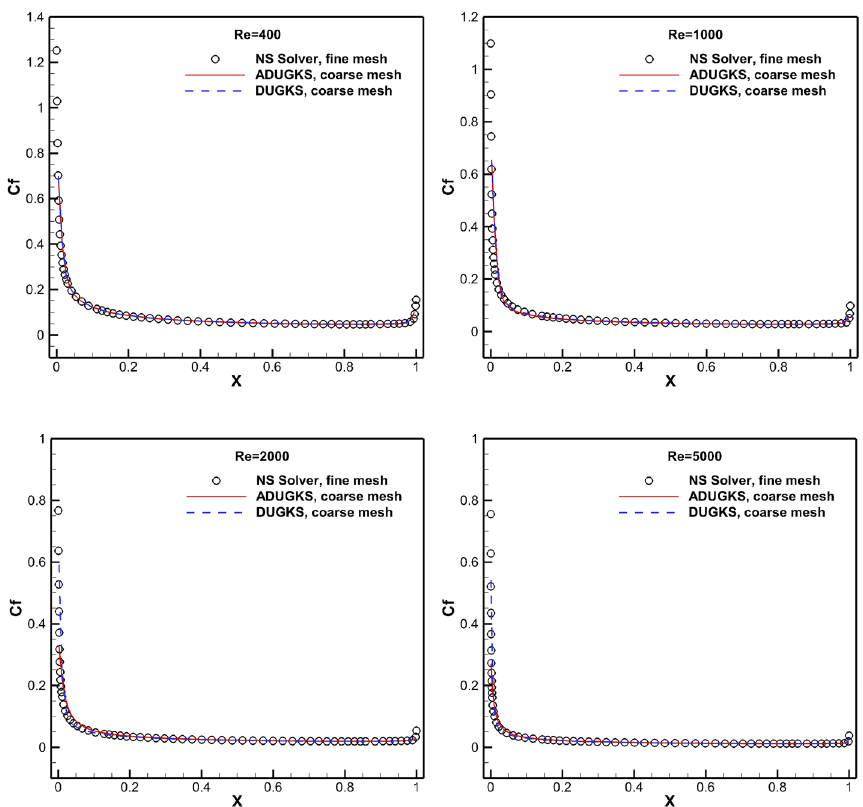
Fig. 13 Distribution of skin friction coefficient on the flat plate in the continuum flow regime calculated by the coarse mesh with different